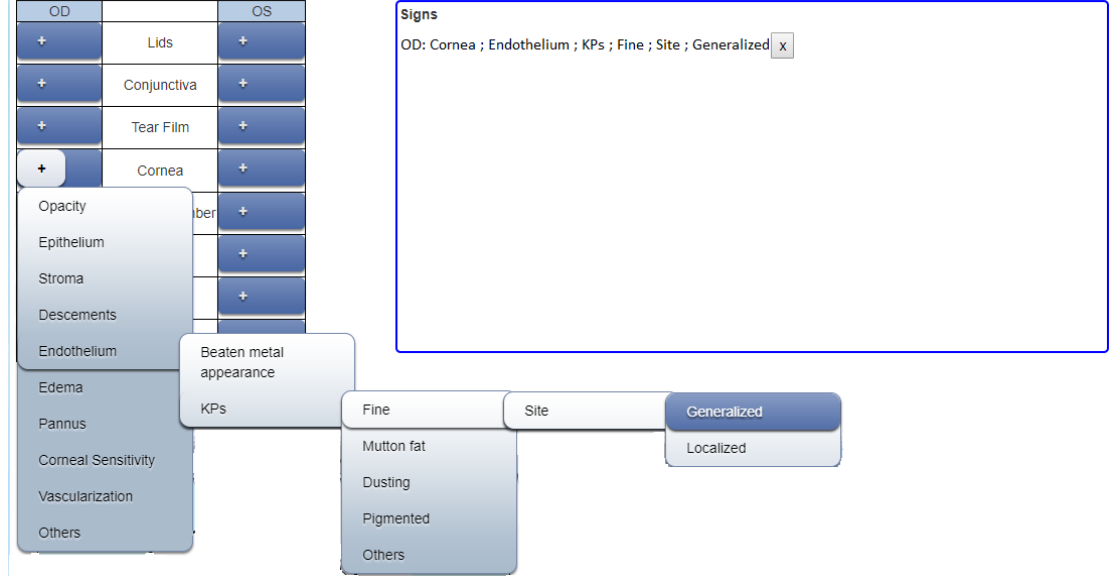
Figure 3. Data entry of symptoms through selection: A symptom is added for the cornea of the right eye shown in the sign pane on the right side of the screen; if a symptom cannot be found, “Others” is the option where new symptoms can be added.